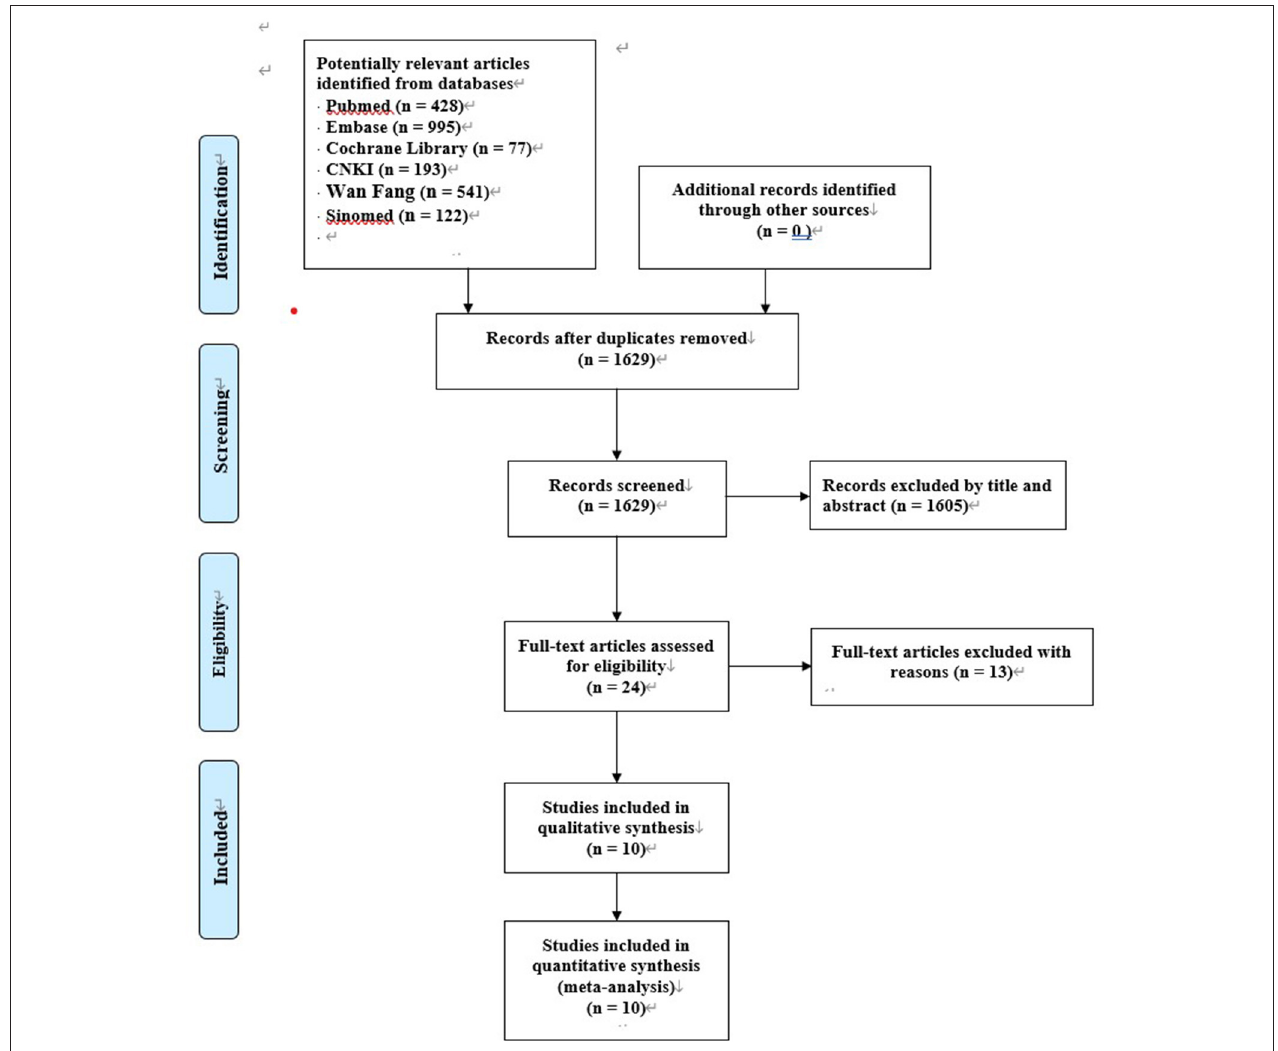
FIGURE 1 | PRISMA diagram of literature searching and screening process.